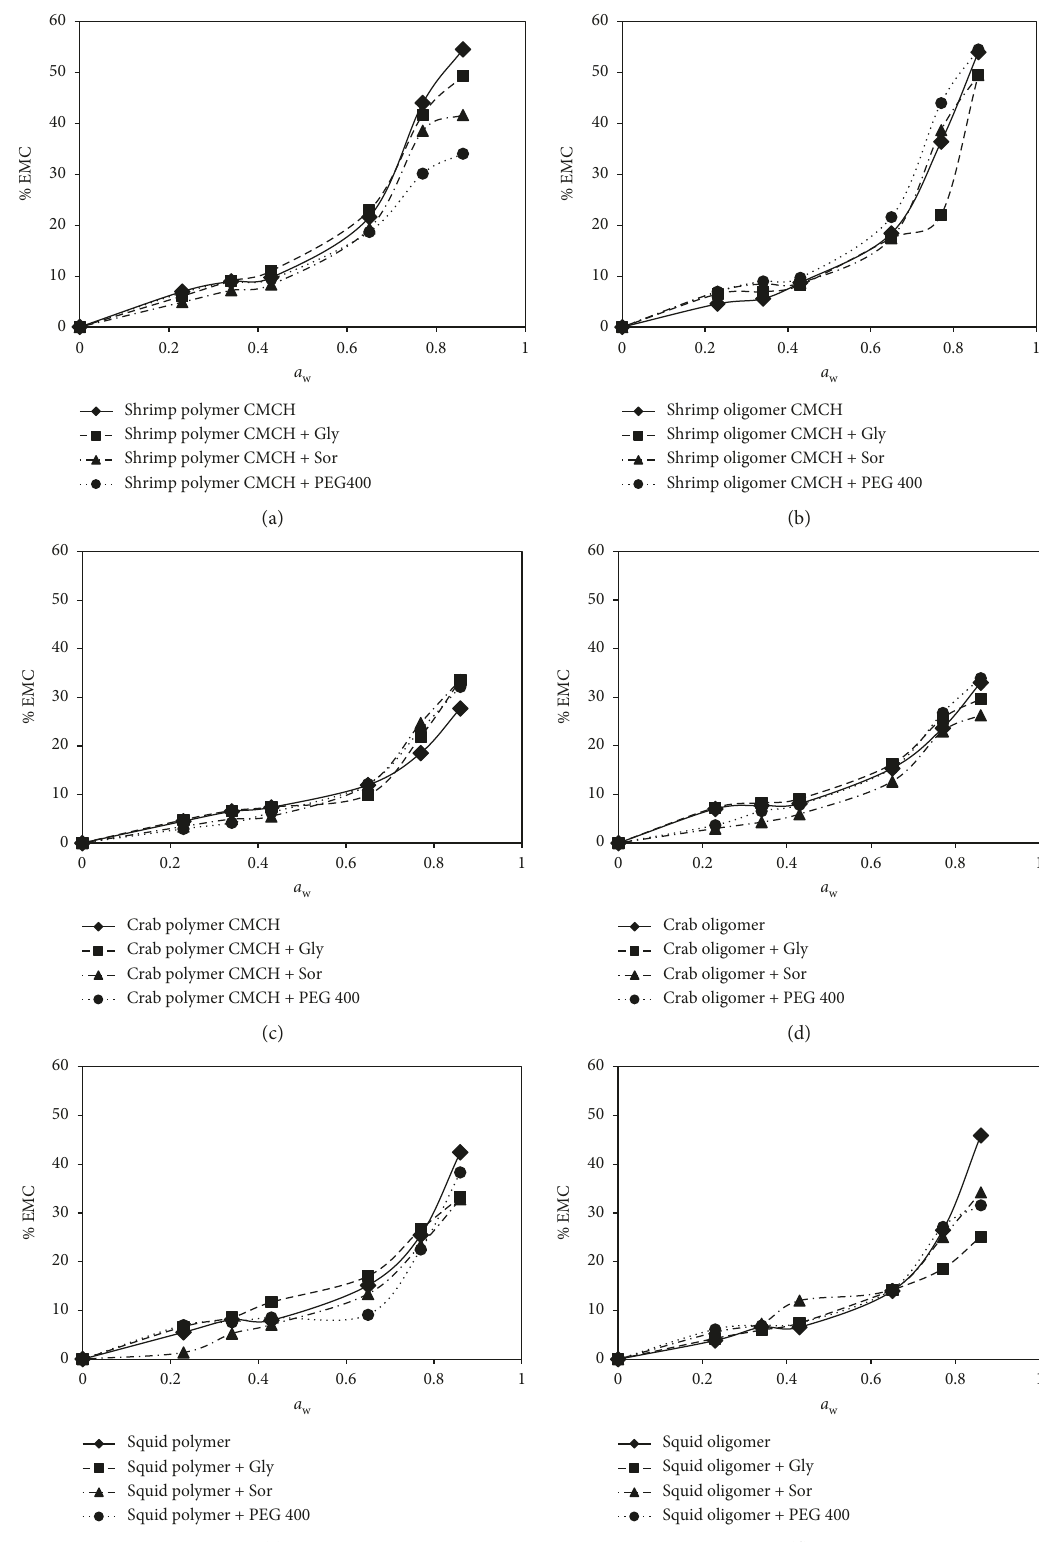
Figure 2: The moisture sorption isotherms of CMCH films blended with the plasticizer: shrimp polymer CMCH films (a); shrimp oligomer CMCH films (b); crab polymer CMCH films (c); crab oligomer CMCH films (d); squid polymer CMCH films (e); squid oligomer CMCH films